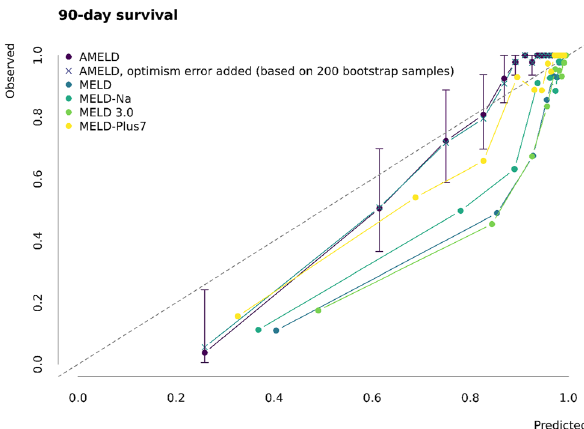
Figure 3: Calibration of AMELD in comparison to MELD, MELD-Na, MELD 3.0, and MELD-Plus7. The points mark the mean predicted survival of 50 patients per interval against their observed mean survival. The error bars correspond to the 95% con fi dence interval of the survival